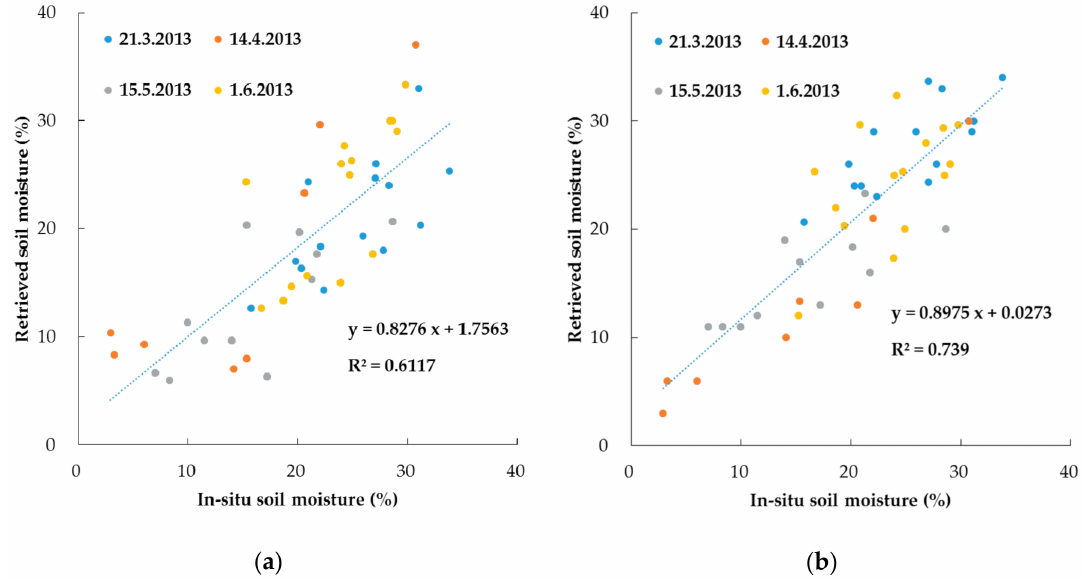
Figure 7. Comparison of soil moisture between measured and retrieved under two combinations: ( a ) WCM-CEM er ; ( b ) MWCM-CEM.